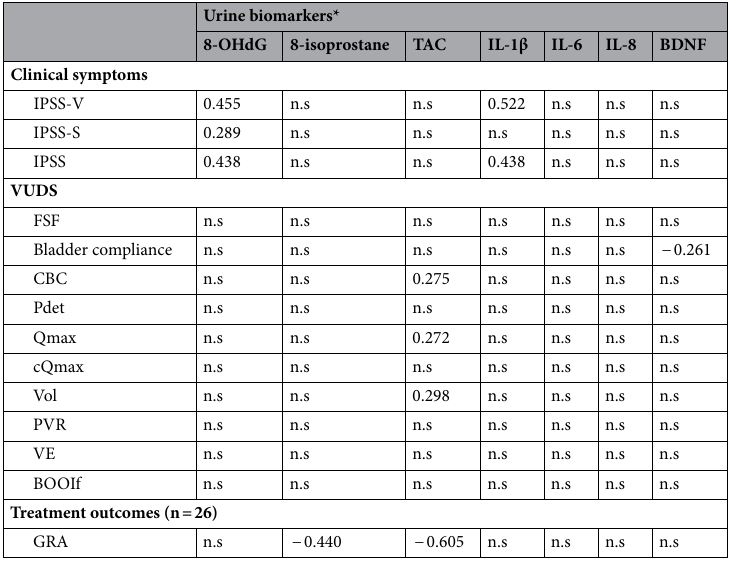
Table 3. Correlation coefficient (r value) between urine biomarker levels and the clinical characteristics of patients with DV. DV Dysfunctional voiding, 8‑OHdG 8-hydroxy-2-deoxyguanosine, TAC Total antioxidant capacity, VEGF Vascular endothelial growth factor, NGF Nerve growth factor, BDNF Brain-derived neurotrophic factor, IPSS International prostate symptom score, IPSS‑S International prostate symptom